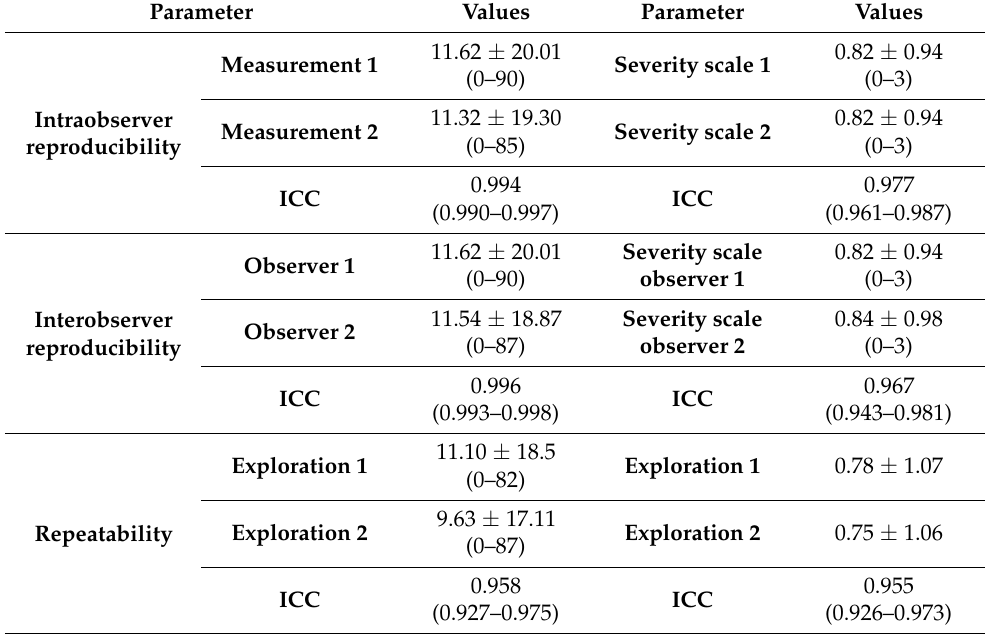
Table 2. Reproducibility of OCT glistening measurements on the IOL (mean ± standard deviation) (N = 50